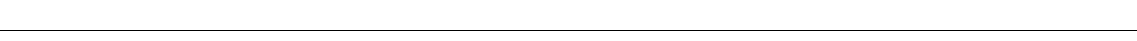
Figure 5 | Down-regulation of p63 ameliorates p53 knockdown- and high fat diet-induced steatosis. ( a ) p63 protein levels in the liver of mice with down-regulated p53 fed a standard diet (STD) after a tail vein injection of a lentiviral particle that encodes either GFP or a shRNA p63 ( n ¼ 7 per group). Effect of the simultaneous liver silence of p53 and p63 on: ( b ) hematoxylin-eosin (upper panel) and oil red O staining (lower panel) of mice liver sections ( n ¼ 3 per group); ( c ) total liver TG content, serum AST, ALTand TG levels ( n ¼ 8 per group); ( d ) liver protein levels of FAS, pJNK/JNK, pIRE/IRE, XBP1s, pPERK, peIF2 a /eIF2 a , cleaved caspase 3, ApoB100 and ApoB48 ( n ¼ 5 per group); and ( e ) mRNA expression of CPT1, ACADM, ACADL and FATP2. ( f ) p63 protein levels in the liver of mice fed a HFD injected with lentiviruses encoding shRNA p63; ( g ) effect of the hepatic down-regulation of p63 in mice fed a HFD in the hematoxylin-eosin (upper panel) and oil red O staining (lower panel) of mice liver sections ( n ¼ 4 per group); ( h ) total liver TG content, serum AST, ALT and TG levels ( n ¼ 11 GFP and 13 sh-RNA p63 mice); ( i ) liver protein levels of FAS, pJNK/JNK, pIRE/IRE, XBP1s, pPERK, peIF2 a /eIF2 a , cleaved caspase 3, ApoB100 and ApoB48; and ( j ) mRNA expression of CPT1, ACADM, ACADL and FATP2. Protein GAPDH or transferrin levels were used to normalize protein levels, and control values (AAV8 GFP and lentivirus Turbo GFP) were normalized to 100%. Dividing lines indicate splicings in the same gel ( n ¼ 7 per group). Uncropped blots of this Figure accompanied by the location of molecular weight markers are shown in Supplementary Fig. 14. Data are presented as mean ± standard error mean (s.e.m.). Statistical significance, * P o 0.05 and ** P o 0.01, was tested using Student t